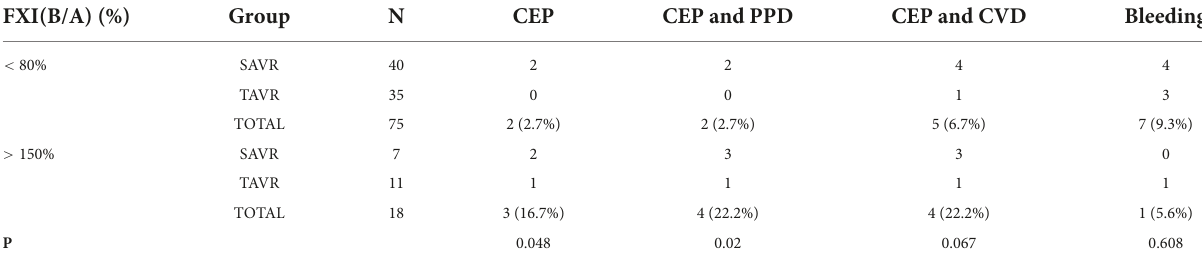
TABLE 2 Complications described in patients with cardiac valve replacement according to the evolution of FXI levels after the procedure. FXI(B/A) (%) Group